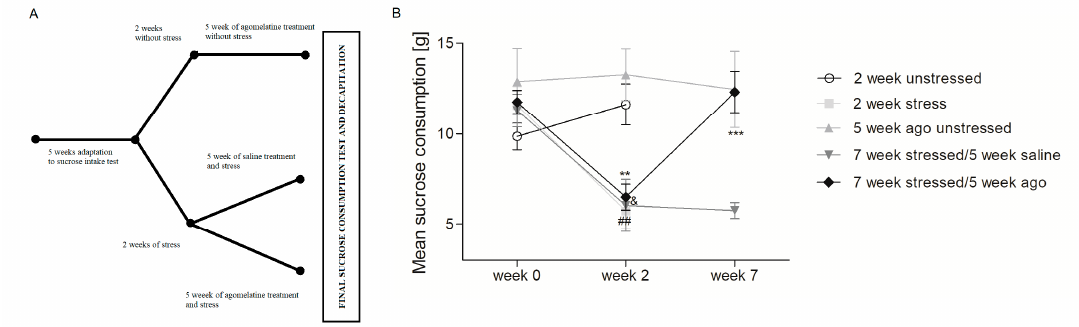
Figure 1. The course of the experiment of chronic mild stress (CMS) and agomelatine therapy ( A ). Sucrose intake test in rats exposed to CMS for two weeks (week 2) and in animals exposed to CMS for seven weeks (week 7) and administered vehicle (1 mL / kg) or agomelatine (10 mg / kg) for five weeks ( B ). The consumption of 1.0% sucrose solution was measured in a 1 h test by weighing pre-weighed bottles. The data represent means ± standard error of the mean (SEM); n = 6; ## p < 0.01 relative to week 2 in the 2 weeks stressed group, & p < 0.05 relative to week 2 in the 5 weeks agomelatine unstressed group, ** p < 0.01 relative to week 2 in the 7 weeks stressed / 5 weeks agomelatine group, *** p < 0.001 relative to week 7 in the 7 weeks stressed / 5 weeks agomelatine group.